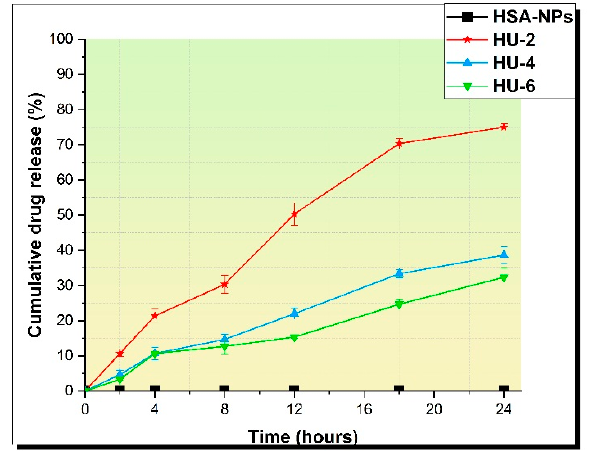
Figure 6. Drug release during 24 h.